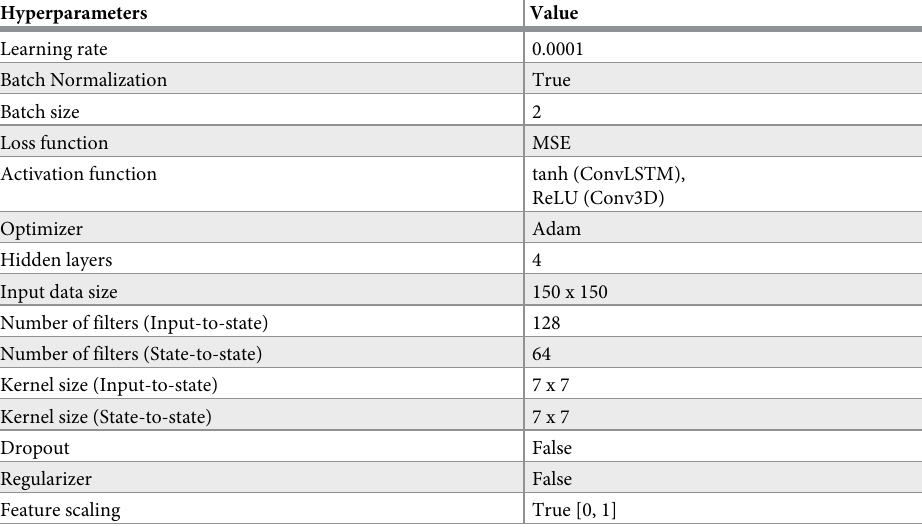
Table 2. Hyperparameters in Convcast